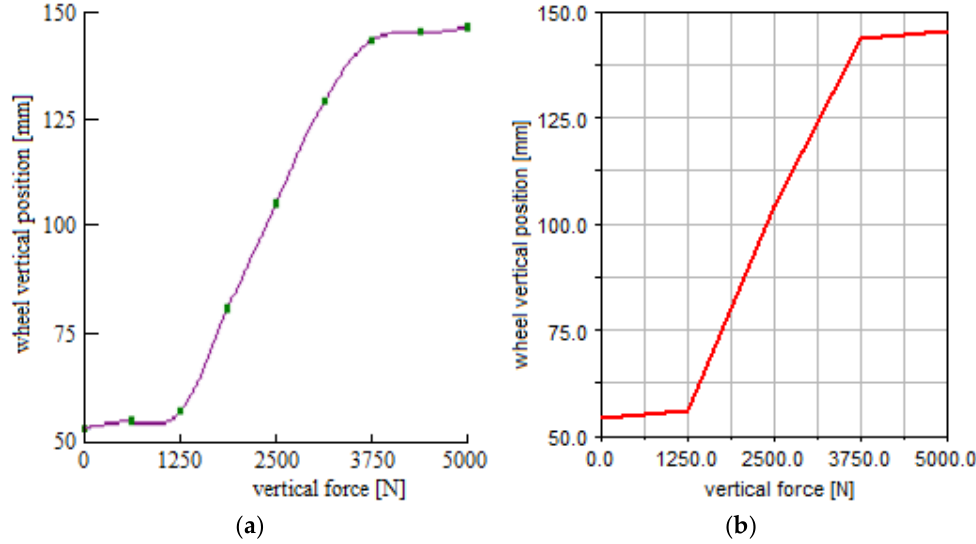
Figure 8. Results of the quasi-static analysis in the stationary regime: ( a ) Proposed method; ( b ) MBS model.